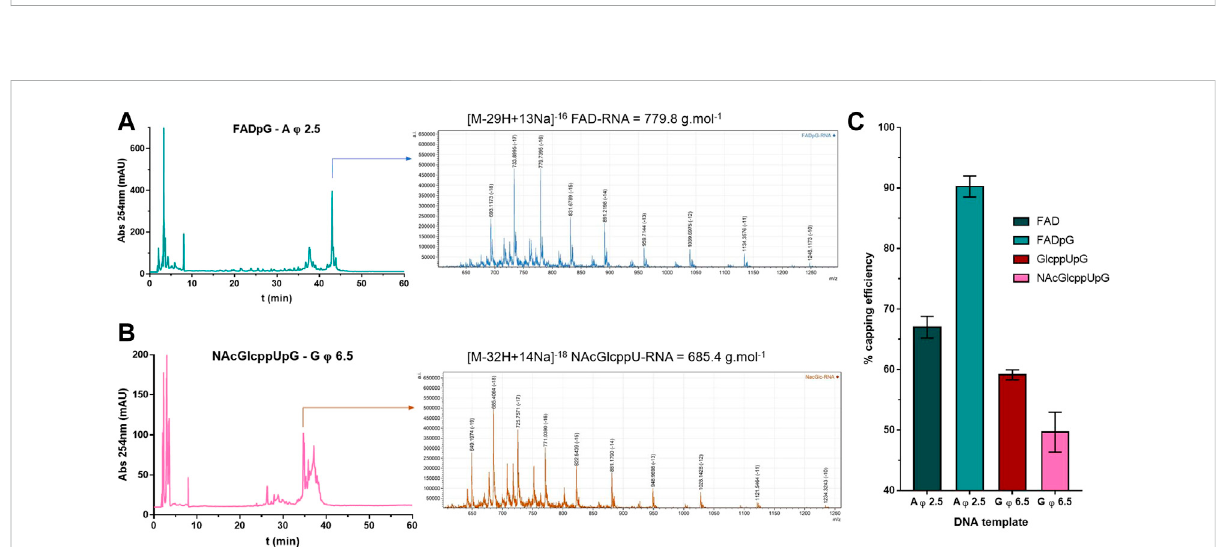
FIGURE 7 (A) HPLC chromatogram and MS spectrogram issued from LC-MS analyses on FADpG initiated IVT RNA using A φ 2.5 DNA template. (B) HPLC chromatogram and MS spectrogram issued from LC-MS analyses on NAcGlcppUpG initiated IVT RNA using G φ 6.5 DNA template. (C) Capping ef fi ciencies for FAD, FADpG, GlcppUpG and NAcGlcppUpG calculated from LC-MS analyses, as mean values from 3 technical